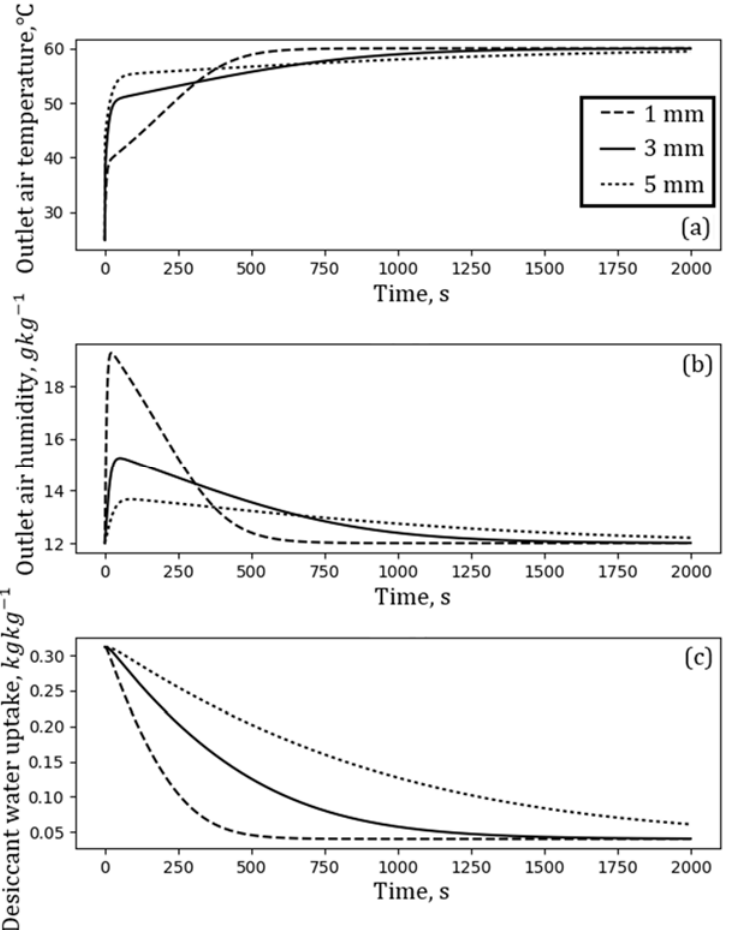
Figure 5. The influence of the desiccant particle diameter on desorption characteristics: ( a ) Outlet air temperature; ( b ) outlet air humidity; and ( c ) desiccant water uptake.